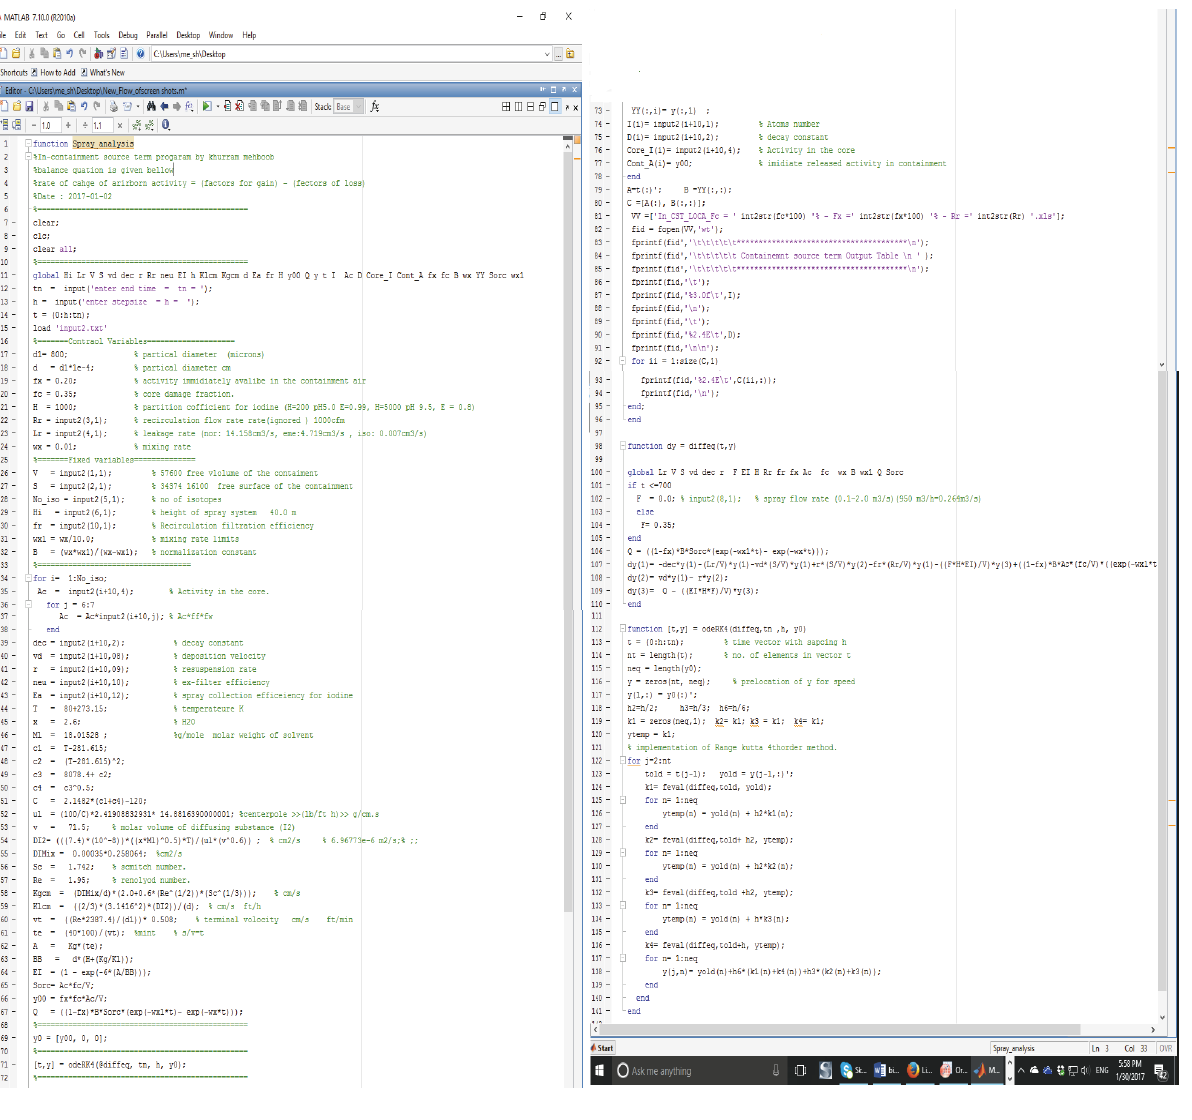
Figure 6: Screenshot of the computer